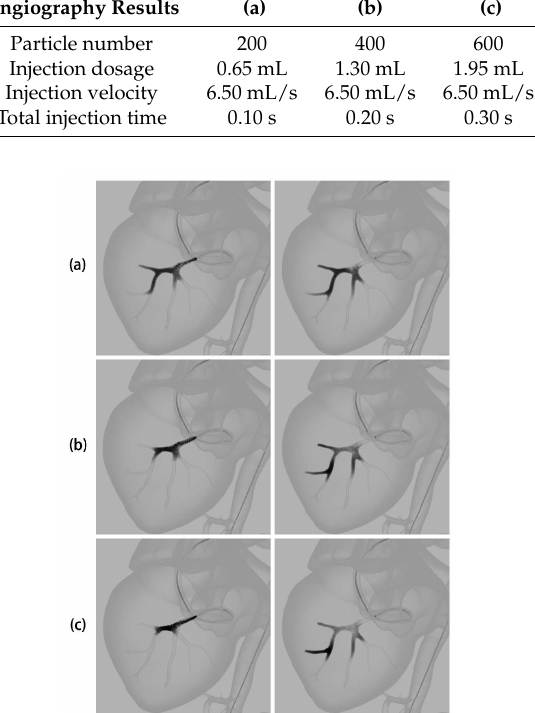
Figure 8. 3D virtual angiography results with various injection velocities. ( a ) Result at the time 0.60 s with an injection velocity 3.25 mL/s; ( b ) Result at 0.30 s with an injection velocity 6.50 mL/s; ( c ) Result at the time 0.15 s with an injection velocity 13.00